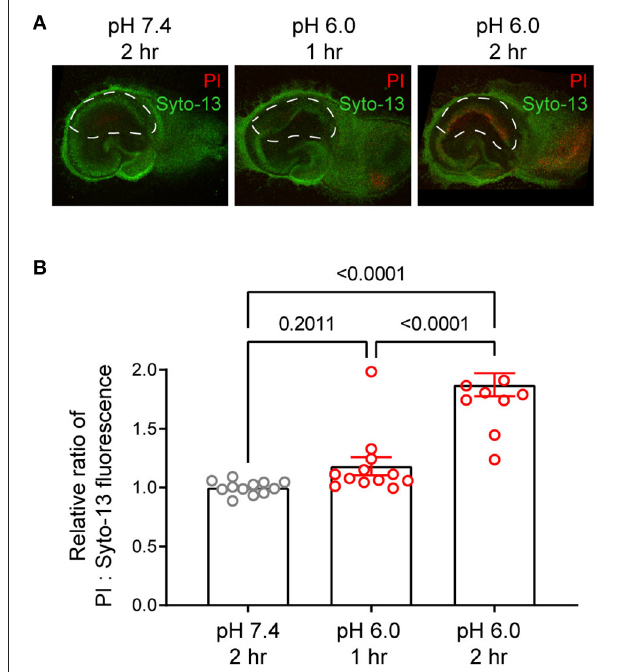
FIGURE 1 | Time-dependent effect of pH 6 on neuronal injury. Organotypic hippocampal slices were treated with medium buffered at pH 7.4 or pH 6.0 for 1- or 2-h as indicated. To determine delayed neuronal injury, slices were stained 24h later with propidium iodide (PI, red) and Syto-13 (green) as described in Methods, and imaged by fluorescence microscopy. (A) Representative confocal images and (B) Quantification of PI:Syto-13 fluorescence ratio. Increased red:green ratio indicates increased neuronal injury. Each dot represents one slice imaged from two separate experiments. ****p < 0.0001. P -values were from 2-way ANOVA with Tukey’s